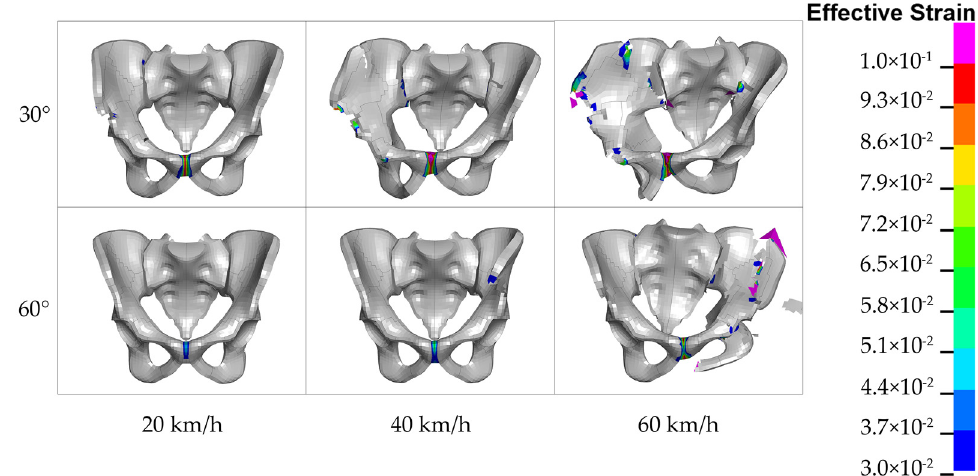
Figure 8. The pelvic deformation, fractures and effective strain contours ( ≥ 0.03) in the simulation results of run-over loading conditions.